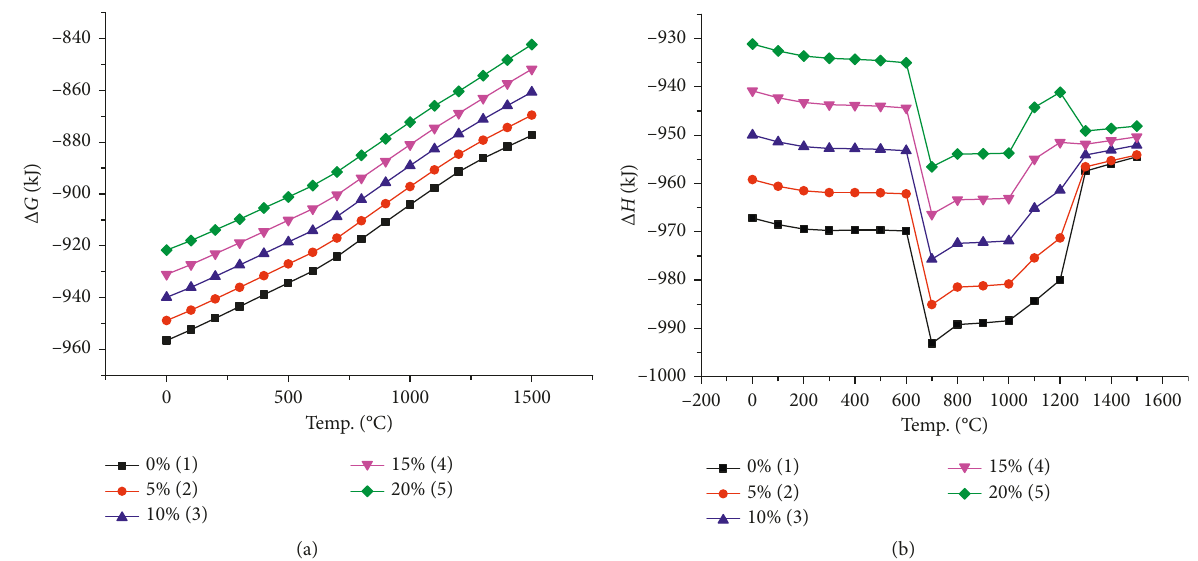
Figure 5: Changes of Gibbs free energy and enthalpy for the five samples.